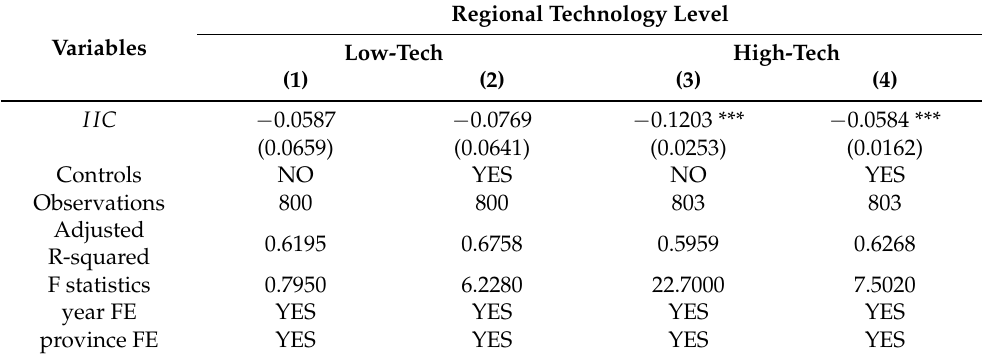
Table 3. Heterogeneity analysis: